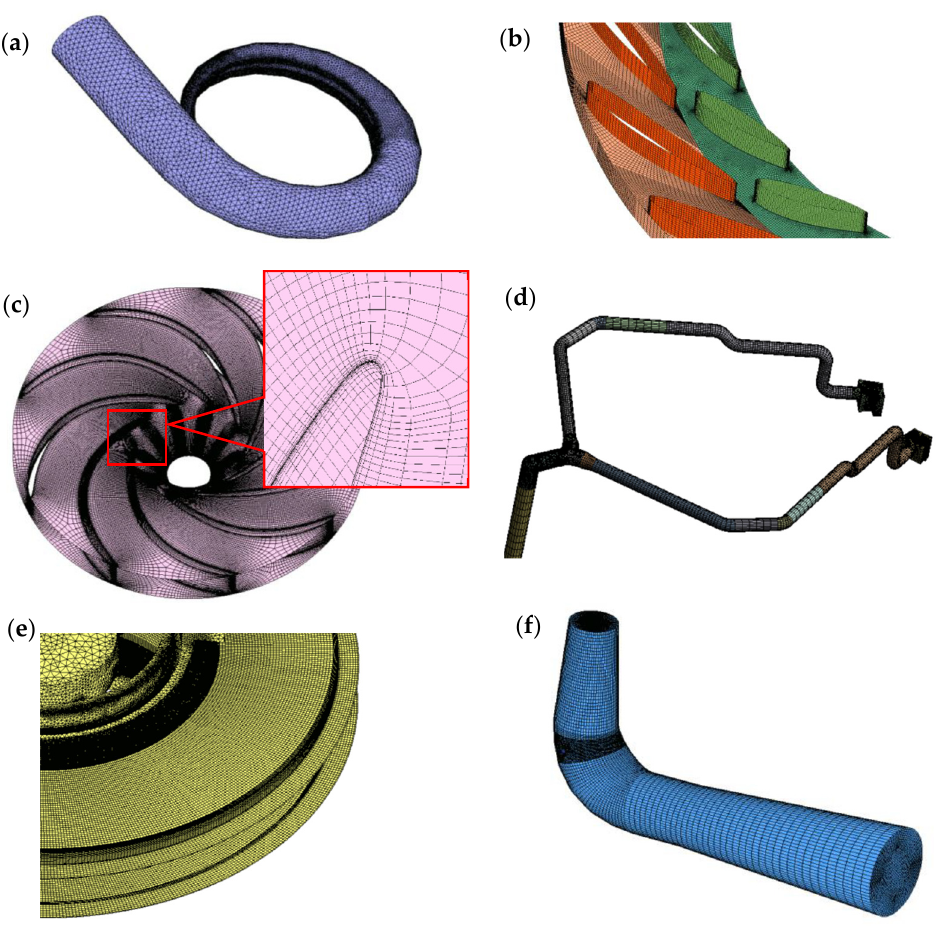
Figure 3. Mesh of the flow field of the pump-turbine: ( a ) spiral casing; ( b ) stay vane and guide vanes; ( c ) runner; ( d ) PBPs; ( e ) seal and gap of the runner; ( f ) draft tube.